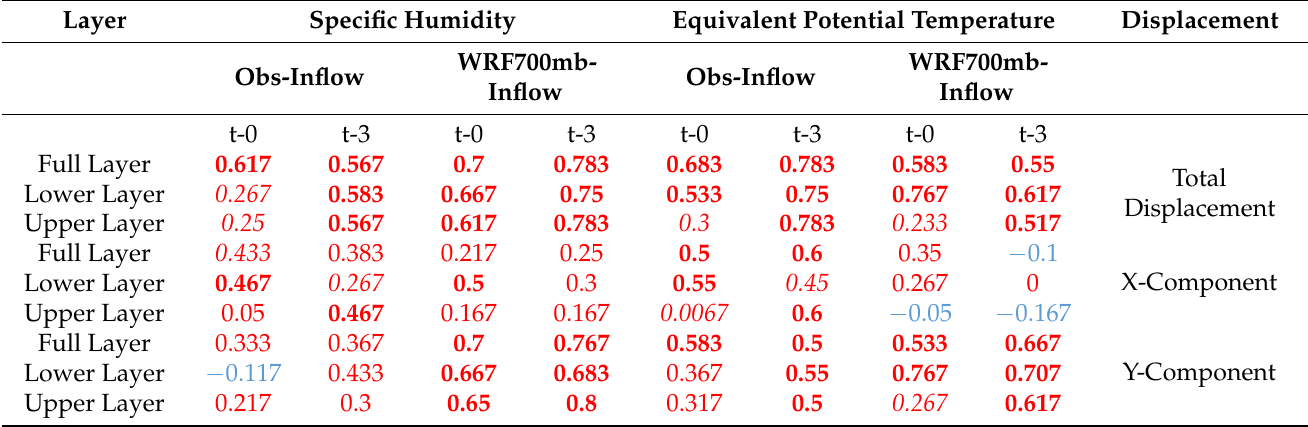
Table 1. Spearman rank correlation coefficients (red indicates positive, blue negative) for all Type C cases simulated with WRF using the Yonsei University (YSU) scheme, and for all combinations of layers and displacements. Values are at time of initiation (t-0), and 3 h prior to time of initiation (t-3), and focus on two regions, the Obs-inflow region (RUC), and the WRF700mb-inflow region (WRF 700 mb). Bold font represents statistically significant correlations (S ≥ | 0.467 | ), regular font not statistically significant correlations (S < | 0.400 | ), and if a non-significant value was an outlier and the t-1 and t-2 values (which are not shown) were both significant, the value is indicated in